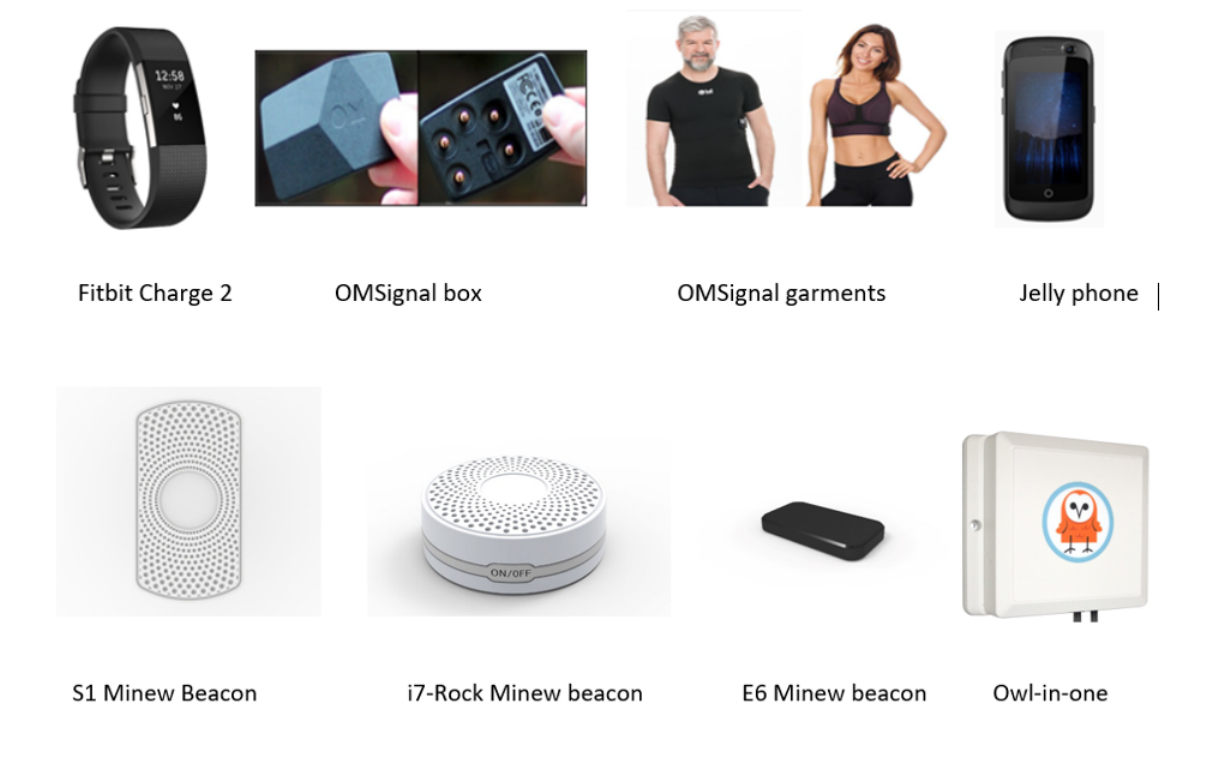
Figure 1. Sensors used in the TILES project. This figure includes both wearable and nonwearable sensors that we used for this study. TILES: Tracking Individual Performance with